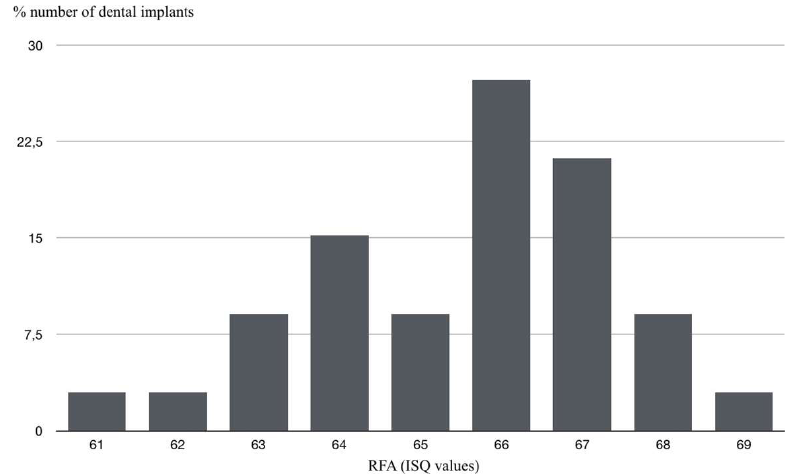
Figure 5. Numbers of dental implants (%) according to RFA (ISQ values). Marginal bone loss was as follows: Group 1 (67.6% presented no thread loss (a sin- gle thread represents 0.7 mm); 17.6% 0.5 thread lost; and 14.7% 1 thread lost) (Figure 6a); Group 2 (48.3% presented no thread loss; 27.6% 0.5 thread lost; 20.7% 1 thread lost; 3.4% 3 threads lost) (Figure 6b); Group 3 (59.6% presented no thread loss; 4.3% 0.5 thread lost; 19.1% presented 1 thread lost; 4,3% 1.5 thread lost; 10.6% 2 threads lost; 2.1% 3 threads lost) (Figure 6c).